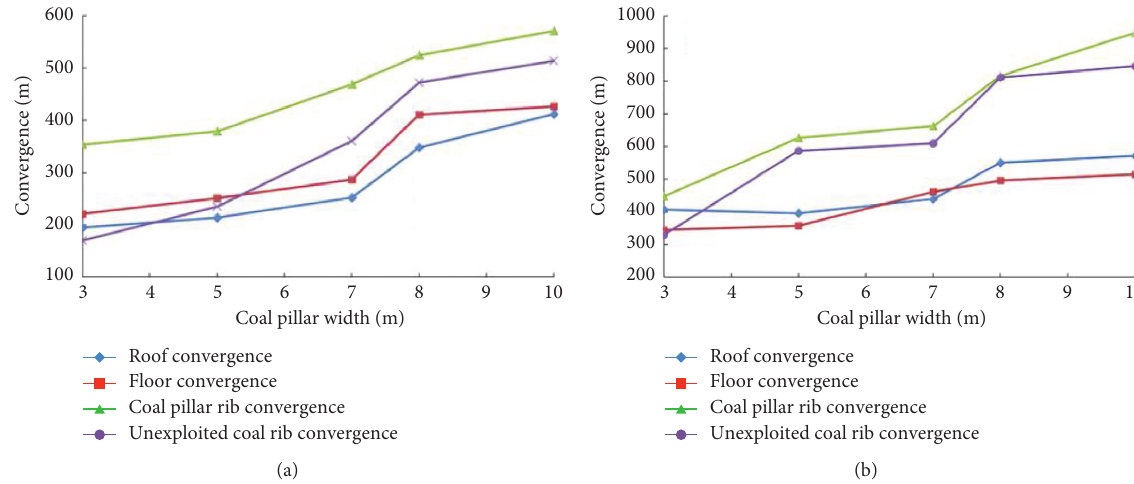
Figure 10: Relationship between the deformation of the surrounding rock and coal pillar width during roadway driving and extraction periods. (a) The roadway driving period. (b) The extraction